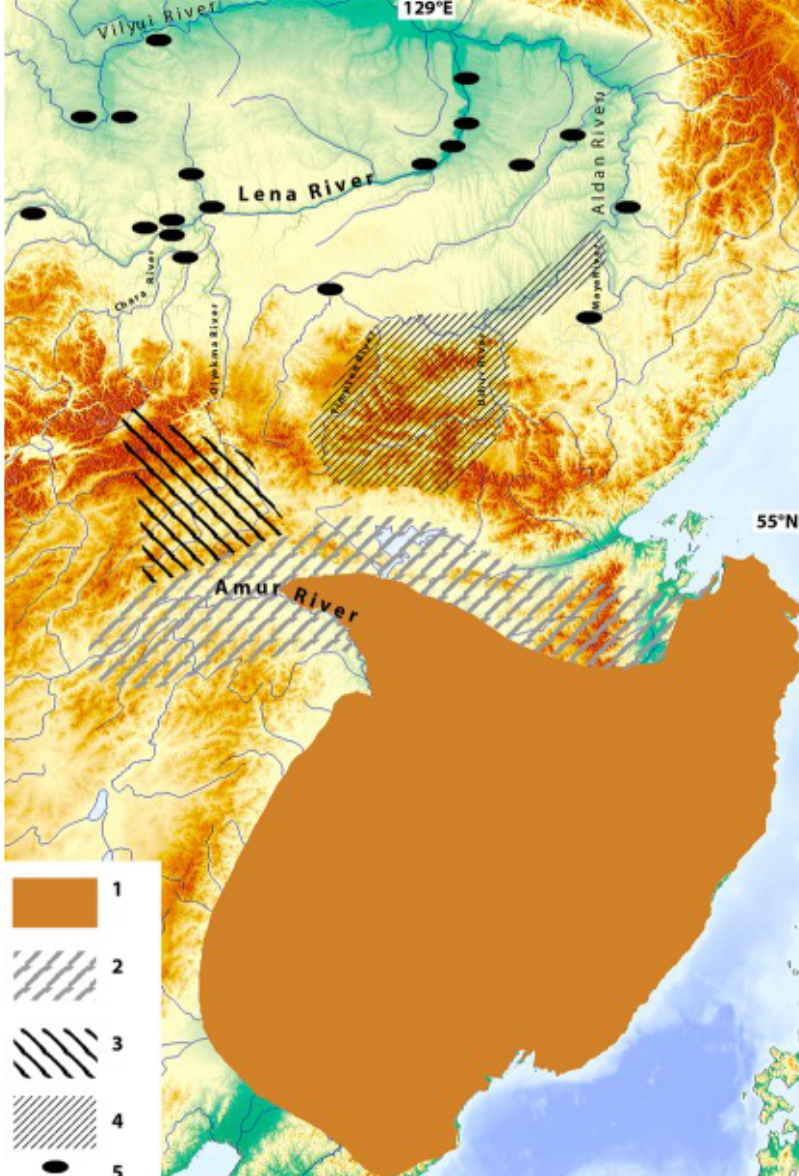
Fig. 1. Extant distribution of the Mandarin Duck in Siberia and Far East. 1 – Continental breeding range as suggested by the last version of IUCN Red List of Threatened Species (BirdLife International 2012); 2 – Breeding range extending since the 1980s (Kozhemyako et al. 2009; Vischnyakov et al. 2012); 3 – Extent of occurrence in the Olyekma River upper reaches, 1980s–2000s (Vischnyakov et al. 2012); 4 – Extent of occurrence in the Aldan River upper and middle reaches, and its tributaries in the 2000s and 2010s; 5 – Cases of vagrancy in the Lena River basin in the 2000s and